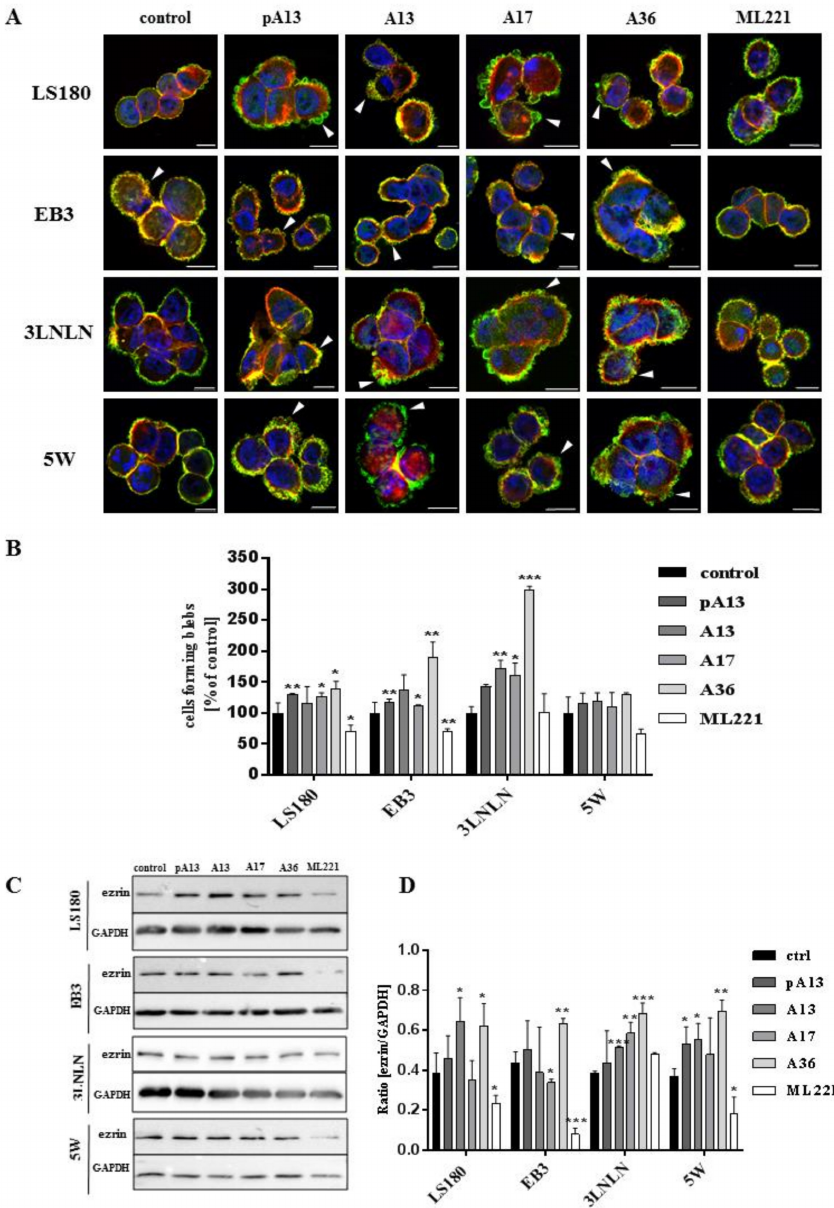
Figure 2. Influence of apelin on blebs formation. ( A ) Representative localization of ezrin (green), filamentous actin (red) and nuclei (blue) in colon cancer cells after apelin peptides (100 nM) or ML221 (100 nM) stimulation. Arrowheads indicate migratory protrusions. Scale bars represent 10 µ m; ( B ) Quantification of the number of cells forming blebs after apelin peptides or ML221 treatment, shown as a percent of control cells. Results are expressed as the mean (cells forming blebs) ± SD of three independent experiments. p ≤ 0.05 (*), p ≤ 0.01 (**), p ≤ 0.001 (***). Representative Western blot; ( C ) and densitometric ( D ) analysis for level of ezrin in tested cells incubated with apelin peptides or ML221. The GAPDH level was shown as a loading control. Results are expressed as the mean ± SD of three independent experiments. p ≤ 0.05 (*), p ≤ 0.01 (**), p ≤ 0.001